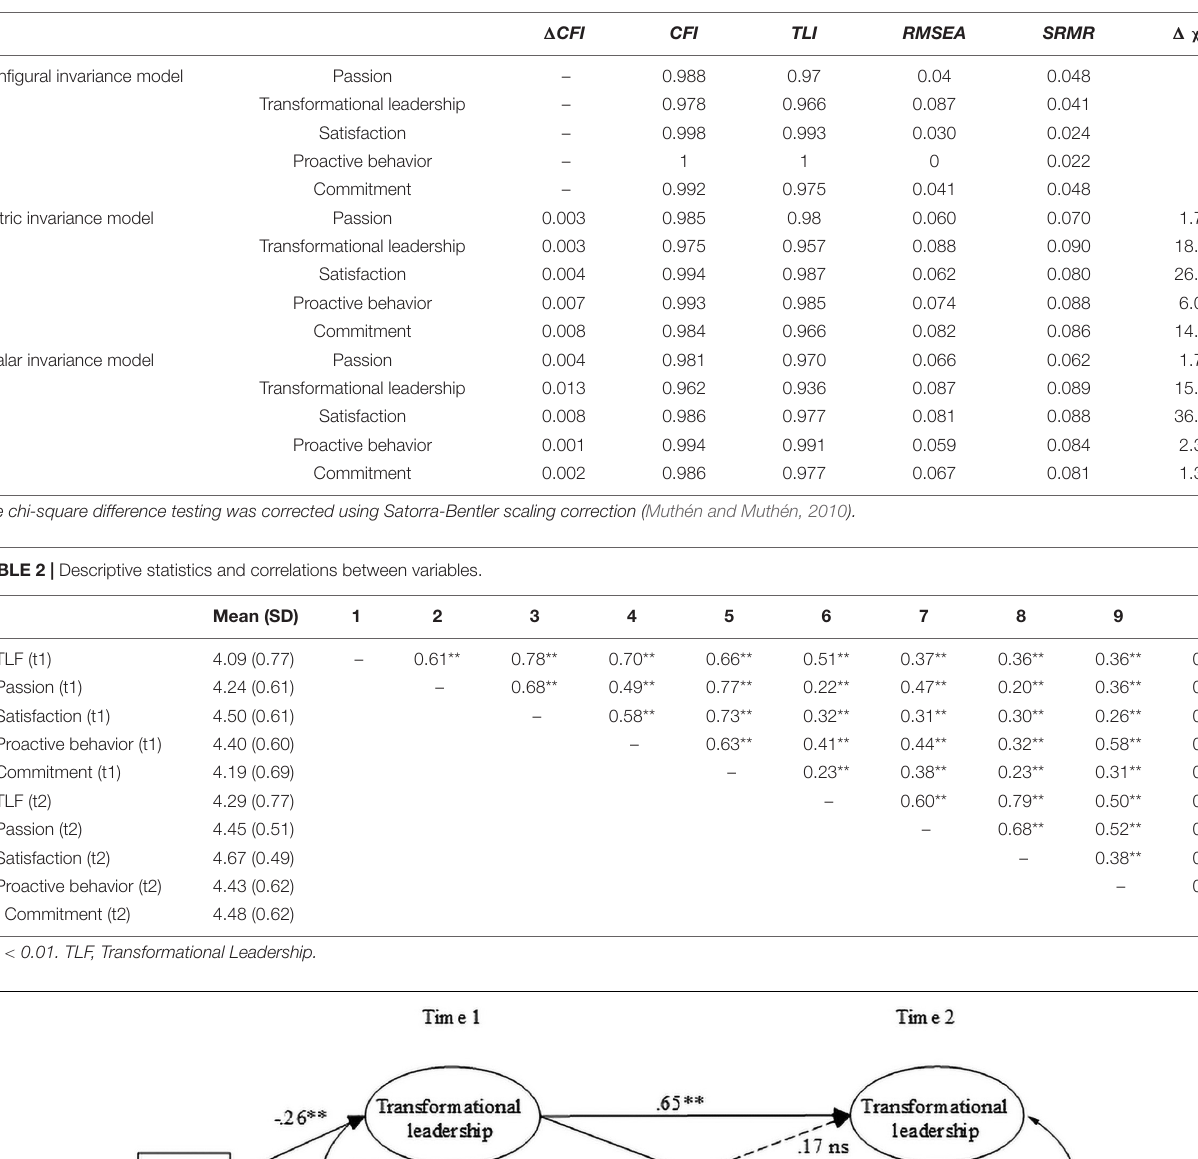
TABLE 1 | Results of longitudinal invariance.